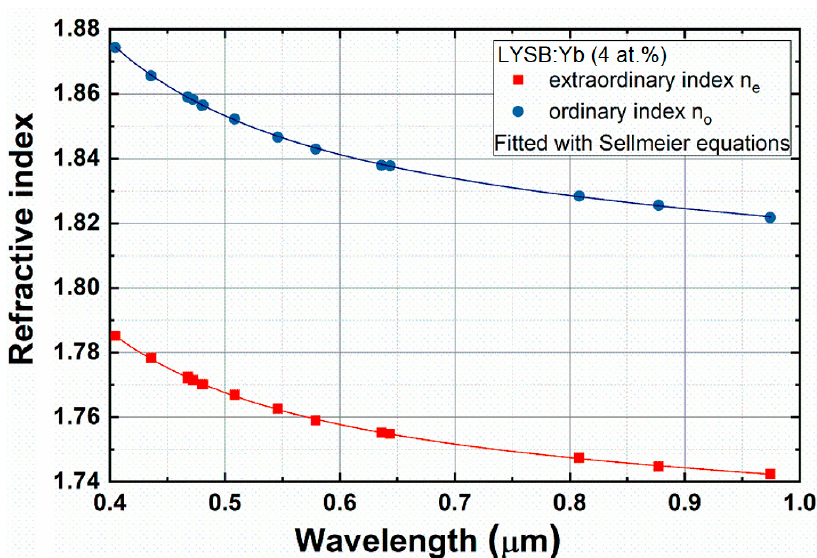
Figure 19. Variation of refractive indices with wavelength in the LYSB:Yb (4 at.%) crystal. Reprinted with permission from ref. [44], copyright 2020, Elsevier.